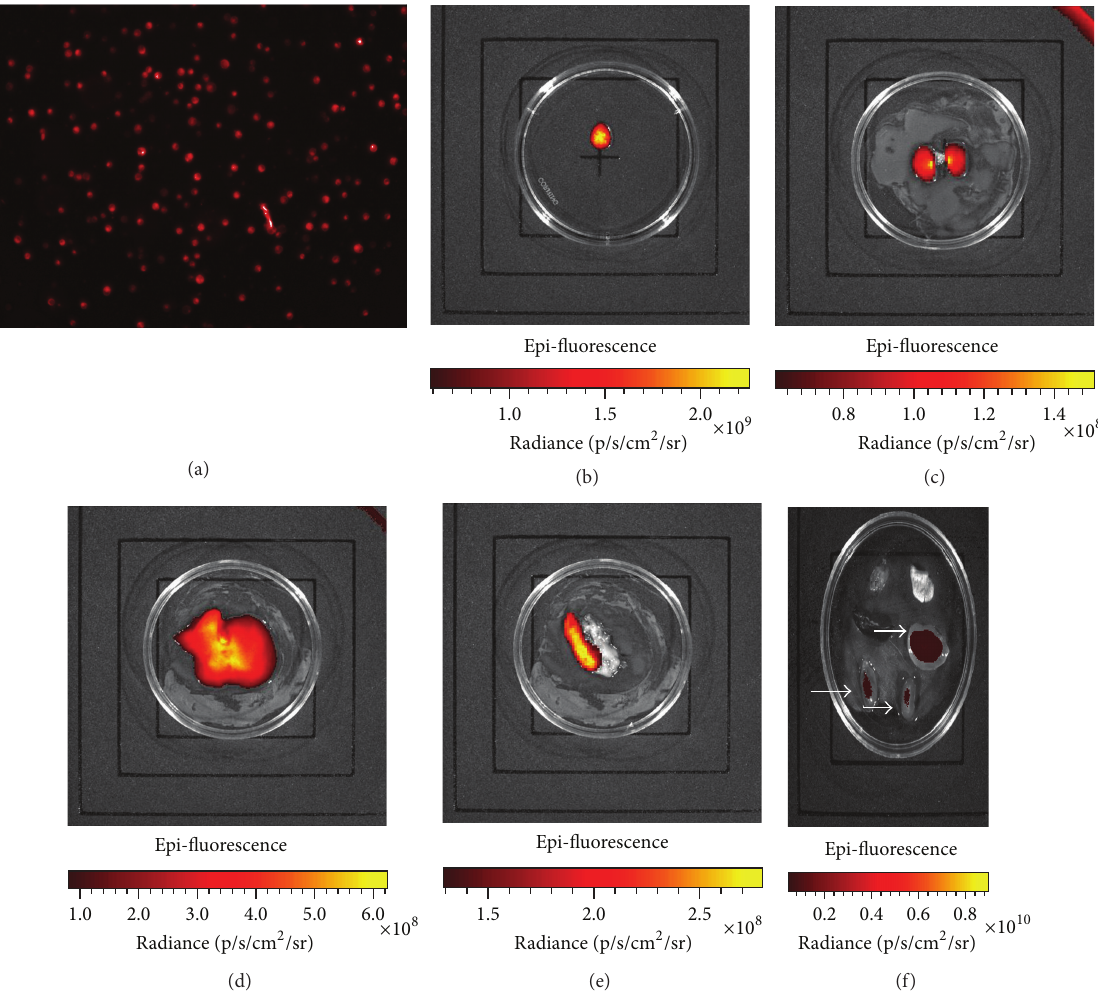
Figure 7: Cells were labeled with a dark red fluorescent marker. (a) Fluorescence microscopy images. (b) Ex vivo image observations. (c–f) Ex vivo imaging results of various organs from the treatment groups. (c) Labeled cells distributed in the kidney. (d) Labeled cells distributed in the liver. (e) Labeled cells distributed in the spleen and pancreas. (f) Observation of labeled cells in the kidneys, spleen, liver, lung, and heart. Arrows show aggregated DiR-stained cells in the liver and two